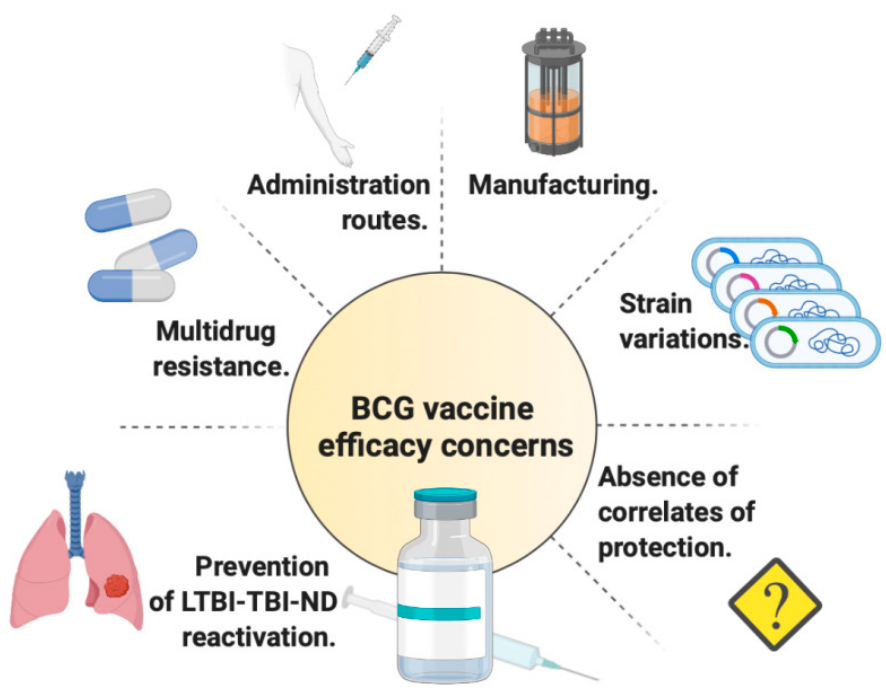
Figure 1. The efficacy of Mycobacterium bovis Bacille Calmette-Guérin (BCG) as a vaccine against tuberculosis (TB), and the most recent findings and questions that need to be addressed are summarized here, as potential areas of research for novel TB vaccine candidates. The value and potential of alternate routes of BCG vaccination other than intradermal, in humans, must be explored. How effective TB vaccines are against multidrug-resistant (MDR)-TB should be determined. Novel preclinical models should shed light on the efficacy of BCG and other TB vaccine candidates in preventing reactivation from latent tuberculosis infection (LTBI)/tuberculosis infection-no disease (TBI-ND). Manufacturing processes that are easier to perform and replicate should reduce variations in viability and immunogenicity. Whether BCG strain variation truly impacts on protection to humans or not should be clarified. Correlates of protection are needed and start to emerge via omics tools.